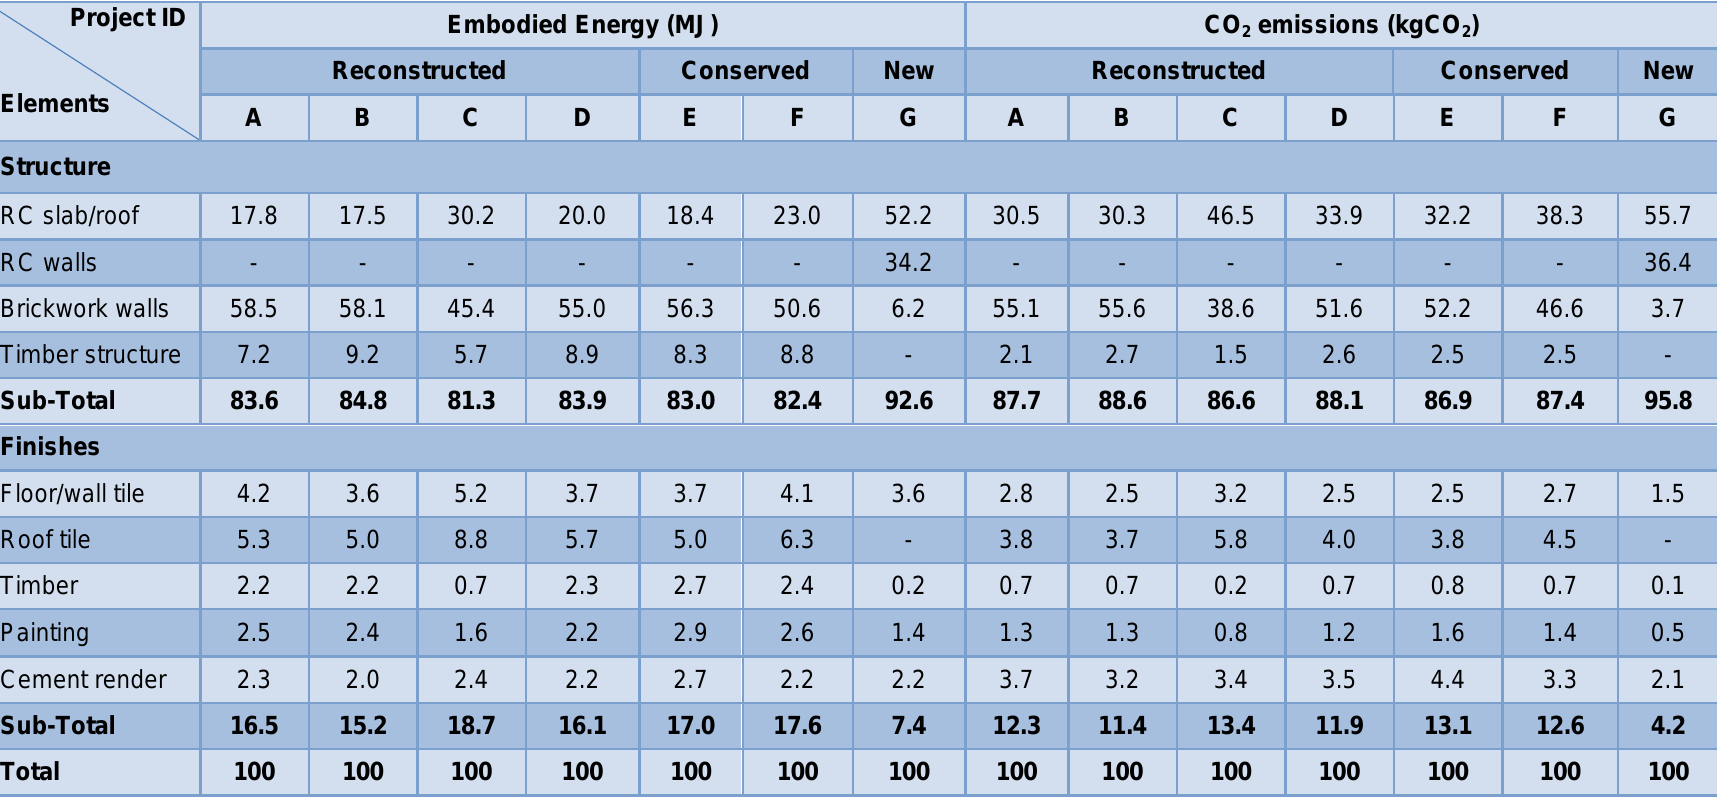
Table 3 Percentage distribution of embodied energy and CO2